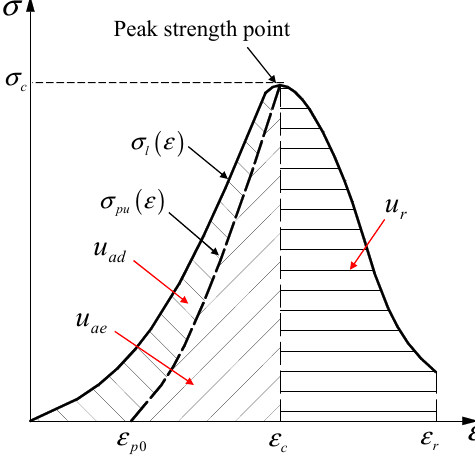
Figure 3. Calculation of modified bursting energy index.